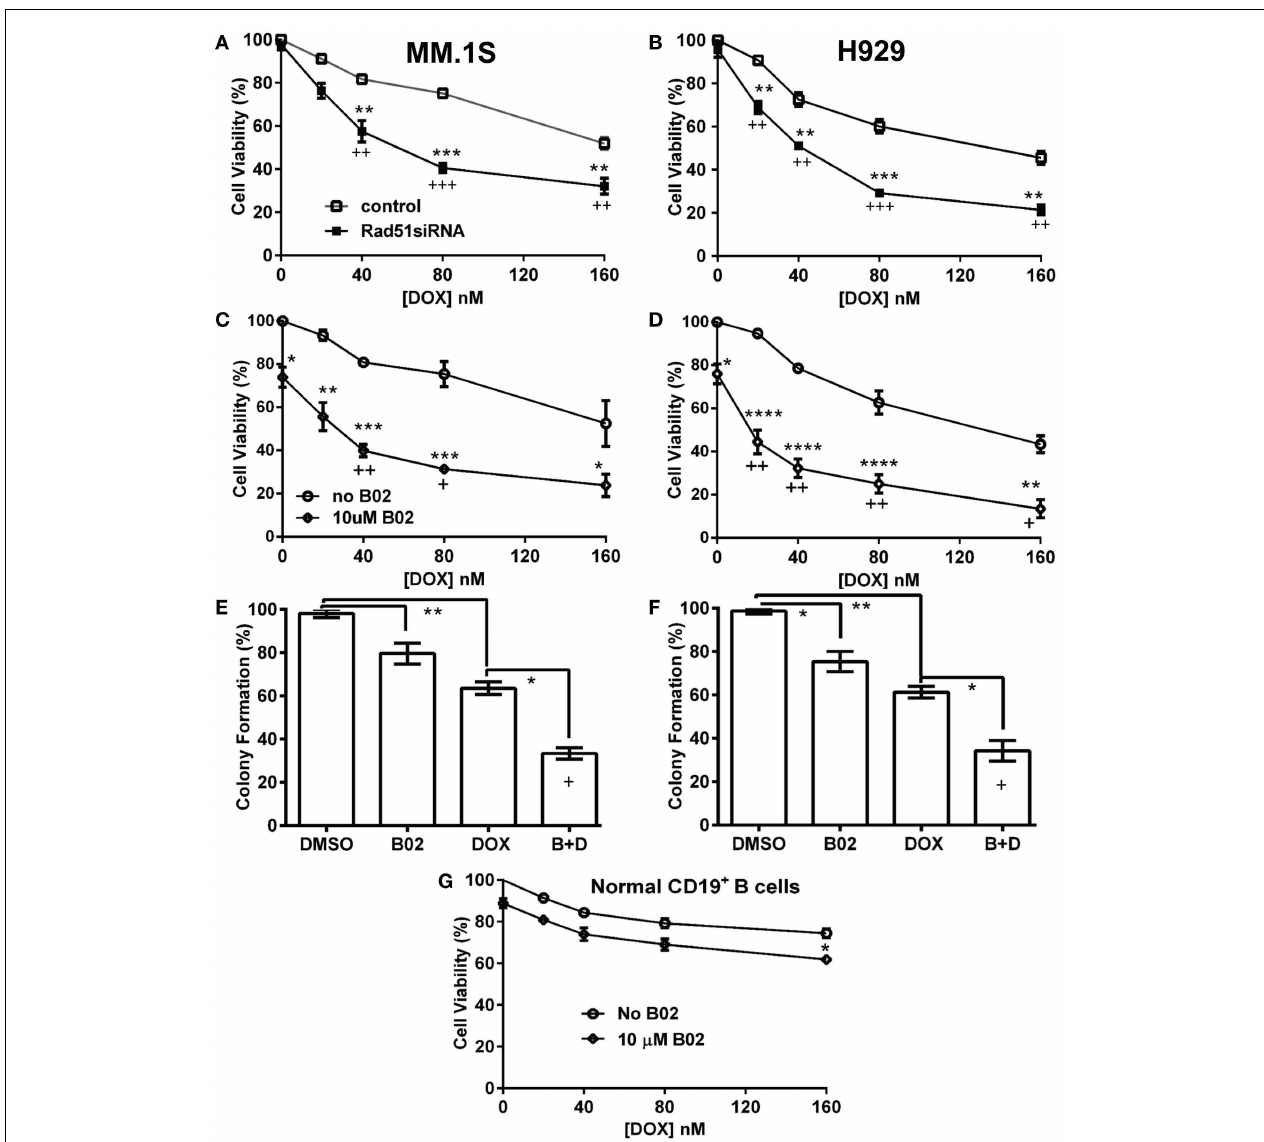
FIGURE 1 | Rad51 inhibitors potentiate doxorubicin (DOX) toxicity in myeloma cells but not in normal B cells . (A,B) Interaction of DOX with anti- Rad51 siRNA for toxicity to myeloma cells in mass culture. Cell lines MM.1S (A) and H929 (B) were treated with DOX at 0–160nM, 24h after transfection with plasmid expressing either a Rad51 -specific siRNA (4) or a scrambled control siRNA. After a further 72h, cell survival and